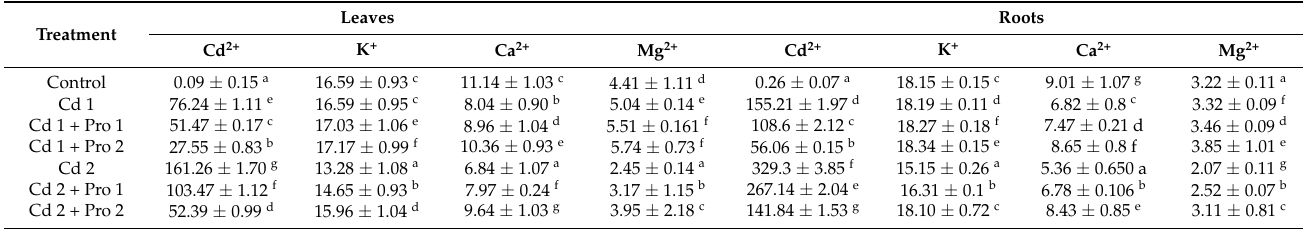
Values represent the means of three replicates ± SD. Cd 1 (4 mg), Cd 2 (8 mg), Cd 1 + Pro 1 (4 mg Cd + 3 mM proline), Cd 1 + Pro 2 (4 mg Cd + 6 mM proline), Cd 2 + Pro 1 (8 mg Cd + 3 mM proline), Cd 2 + Pro 2 (8 mg Cd + 6 mM proline). Different small letters in columns show significant differences and the same small letters show non-significant differences ( p ≤ 0.05) according to Duncan’s multiple range test.